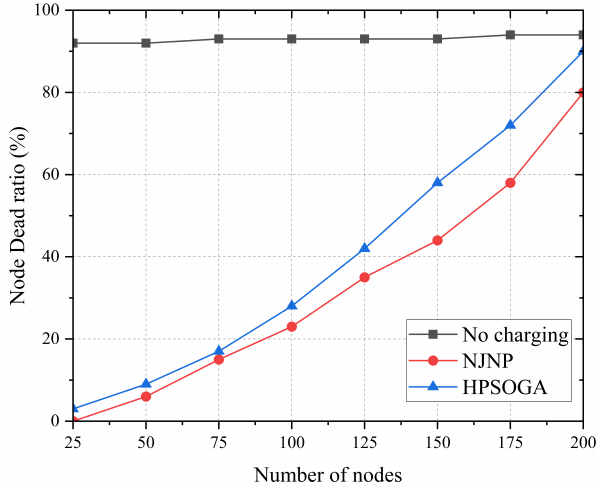
Figure 1. Impact of the number of nodes to the performance of the one-to-one charging